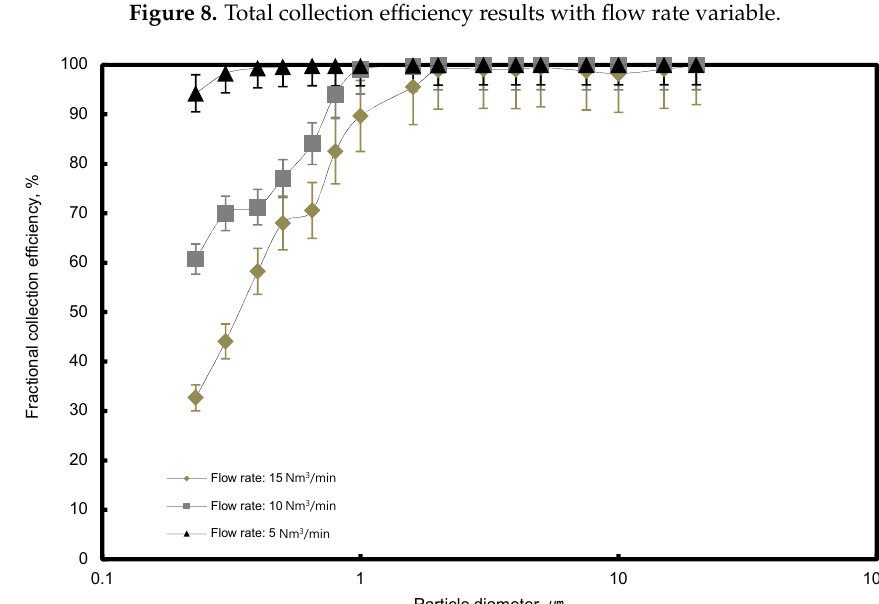
Figure 9. Fractional collection efficiency results with flow rate variable.